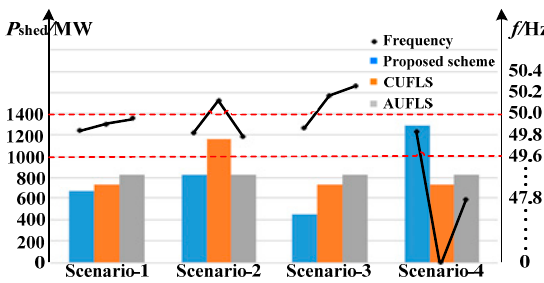
Figure 5. The total LS amount and steady-state frequency of each strategy under various scenarios.